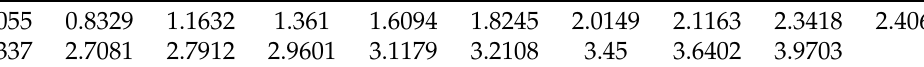
Table 8. The first failure time in years of small electric carts.